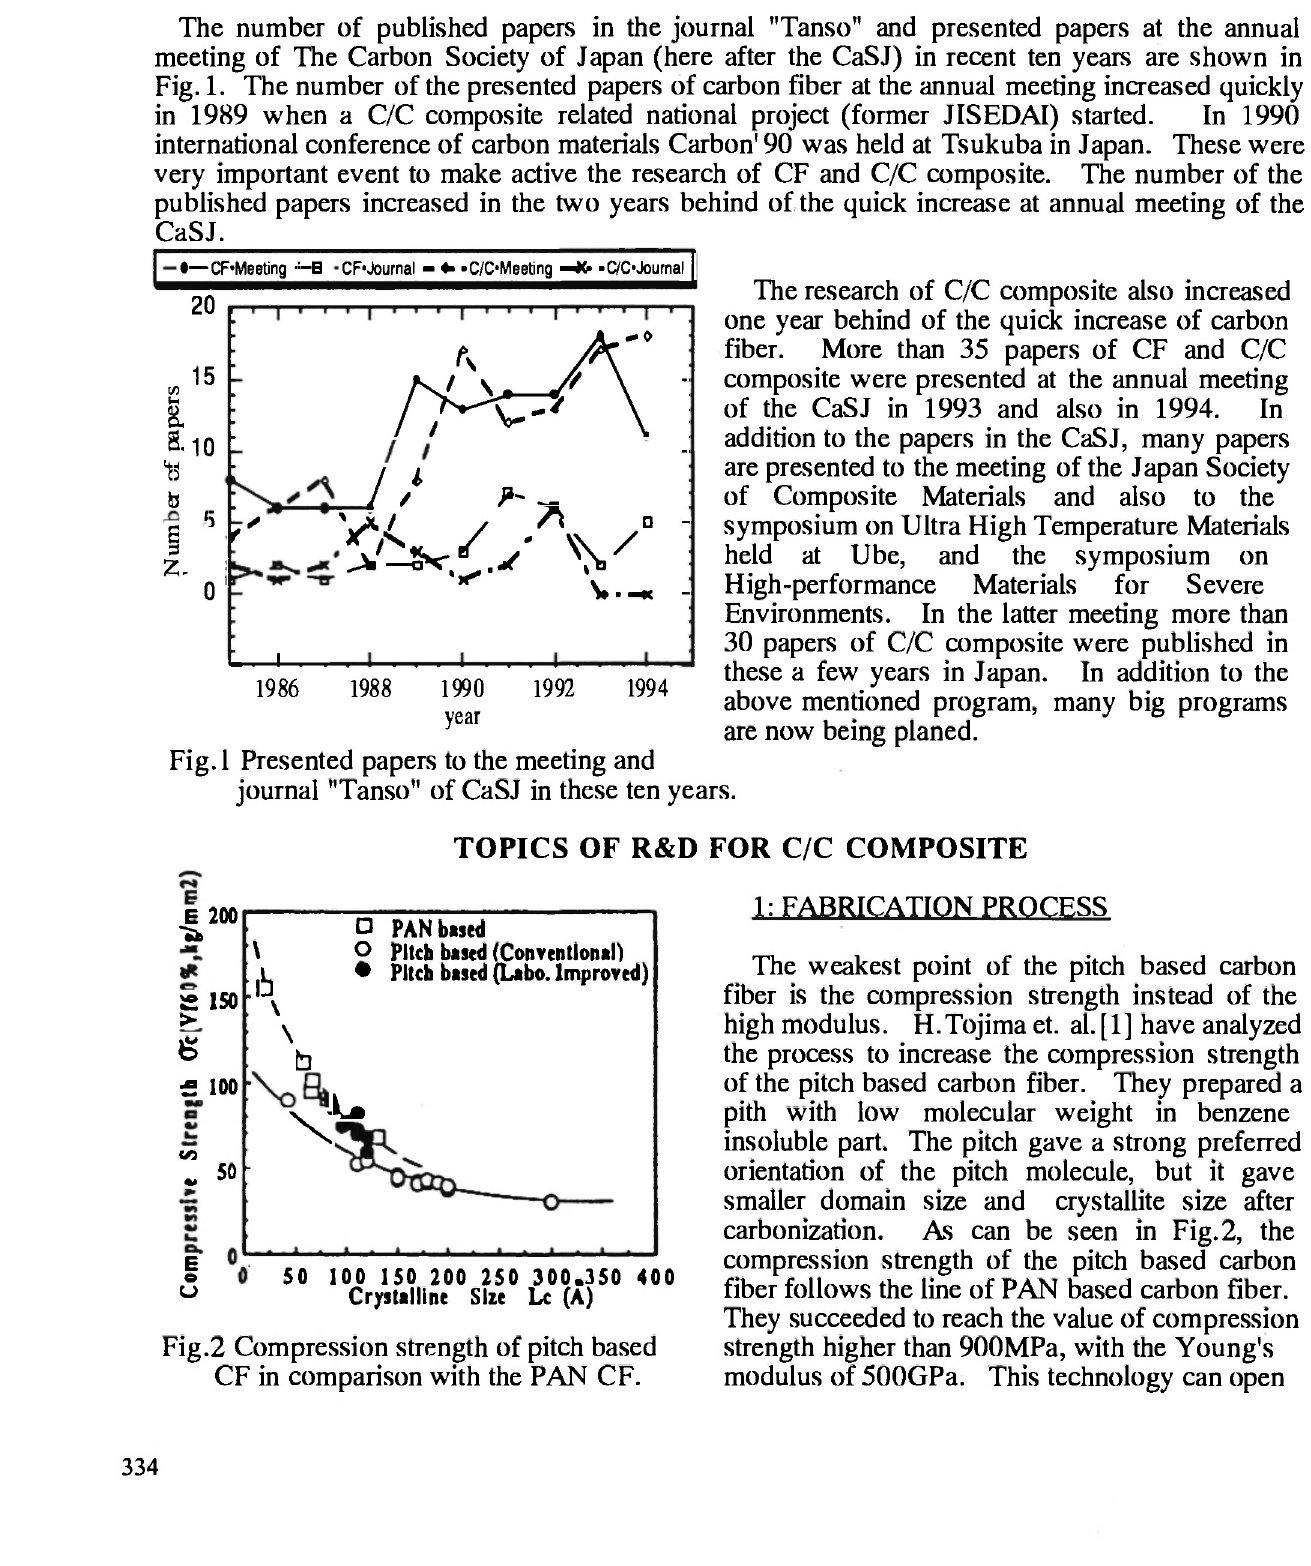
Fig.2 Compression strength of pitch based CF in comparison with the PAN